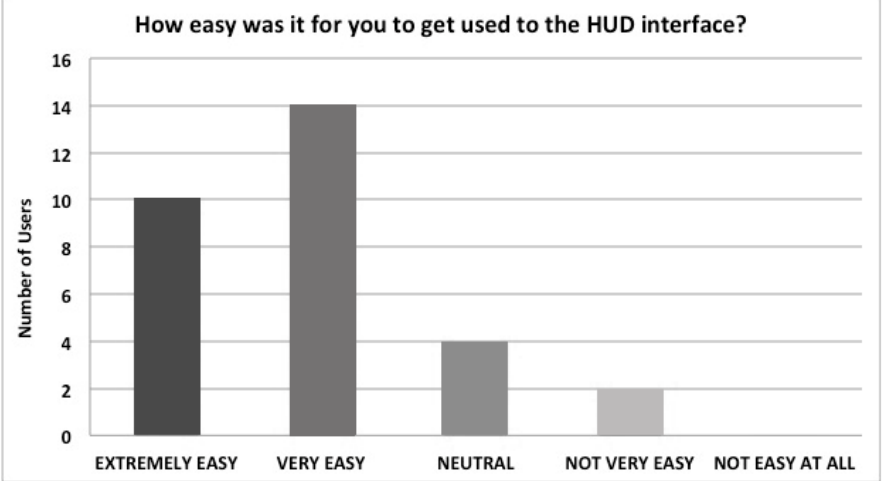
Figure 17. User experience results regarding the ease of use for the HUD interface.